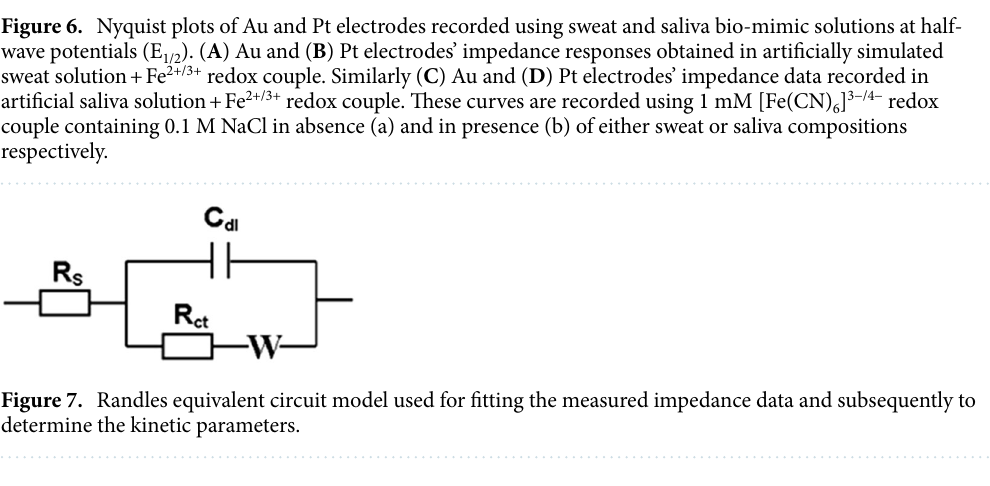
Nyquist plot. R ct represents the resistance offered by the electrode towards the electron transfer reaction. On the other hand, resistance to the mass transfer (diffusion) is denoted by Warburg impedance (W), as a straight line. In case of Au electrode, R ct is determined to be 722.2 Ω for Fe 2+/3+ redox couple in absence of bio-mimic solution and this value is significantly reduced to 377.8 Ω for sweat and 442.4 Ω for saliva compositions. Similarly, Pt electrodes exhibit R ct value of 170.6 Ω for the redox couple in absence of the artificial bio-mimics and this value is drastically changed to 488.8 Ω for sweat and 275.7 Ω for saliva compositions respectively. Similarly, the charge transfer resistance values could also be determined by fitting the measured impedance data to an equivalent circuit. The most common Randles equivalent circuit (modified) shown in Fig. 7 is used for this purpose. It can be seen from this figure that, this particular equivalent circuit has several elements namely the solution resistance (R s ) connected in series to a parallel combination of double layer capacitance (C dl ) and charge transfer resistance (R ct ) along with Warburg impedance (W) connected in series to it. In some cases especially where a depressed semicircle is observed, instead of C dl , a constant phase element (Q) is used in the equivalent